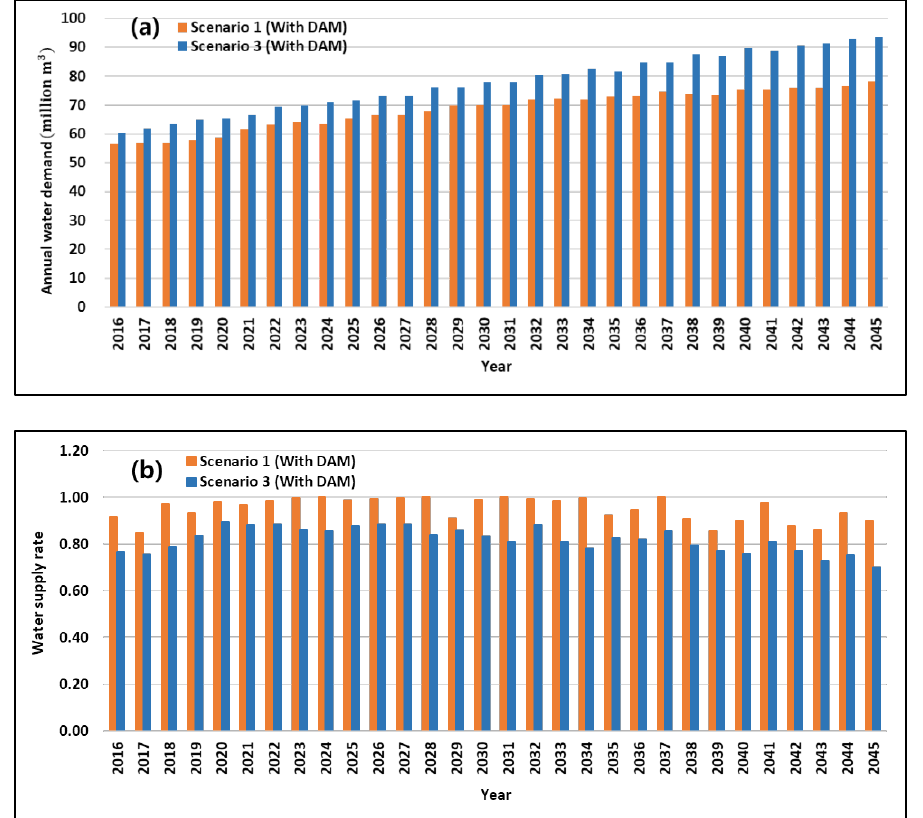
Figure 15. Comparison of Scenarios 1 and 3 for ( a ) Annual water demand and ( b ) Water supply rate.